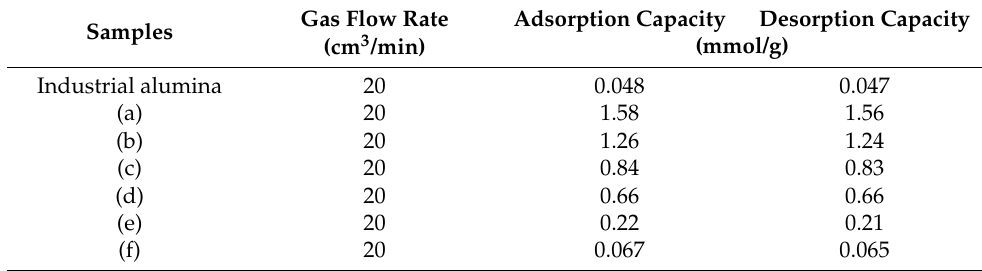
Table 5. CO 2 adsorption–desorption performance of industrial alumina and MA calcined in